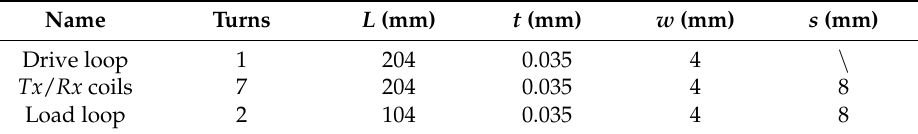
Table 2. Coil structure parameters.